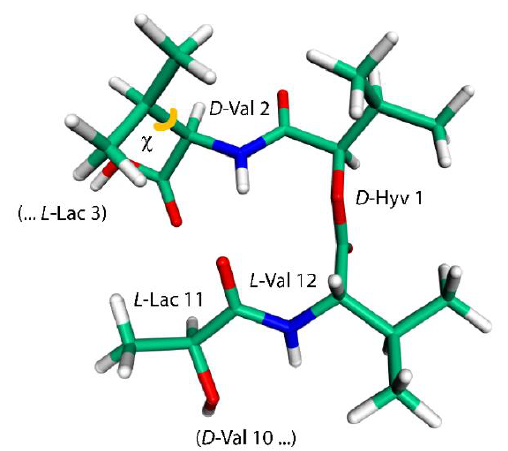
Figure 3. The model employed to calculate changes in the 15 N chemical shielding of the amidic nitrogen of D -Val 2 residue (this geometry features a χ , depicted in orange, of 163°).